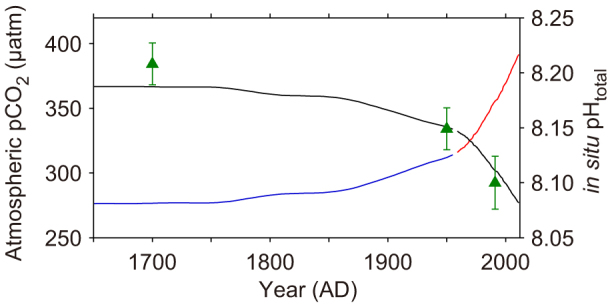
Measured pCO2 from Mauna Loa22 and Law Dome ice core23 (red and blue lines) and estimated pH variation at Tahiti (black line).Green triangles are newly calibrated pH from previously reported δ11B of modern corals from Tahiti and Marquesas1124 (Table S1). Estimated pH from the AD 1700 Marquesas coral was scaled by 0.04 to correct for offset from Tahitian coral values. Error bars are 2σ.